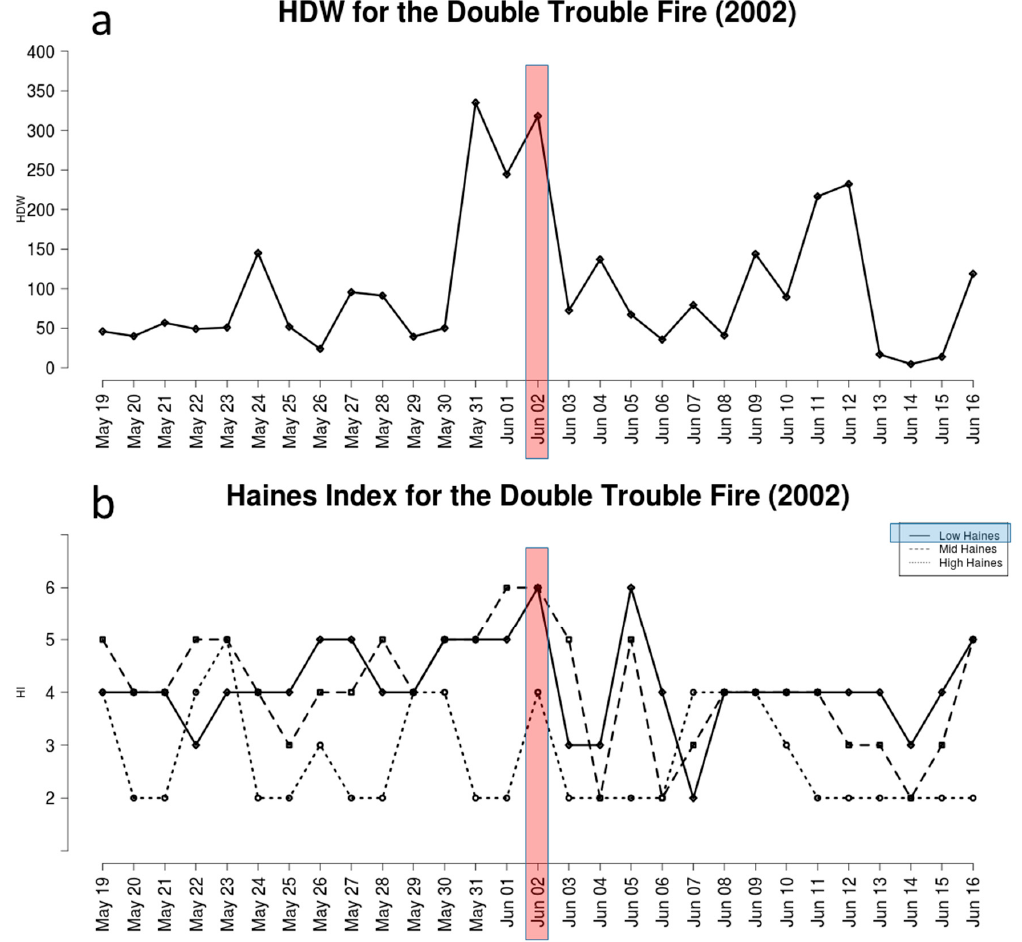
Figure 3. Time series using CFSR data at 40.0° N latitude and 74.0° W longitude from 19 May through 16 June 2002 of ( a ) HDW and ( b ) Low (solid line), Mid (dashed line), and High (dotted line) variants of the Haines Index. The vertical, shaded, red rectangles indicate the day on which the most rapid fire growth occurred on the Double Trouble fire. The Haines Index variant that is recommended for this location is shaded in blue.